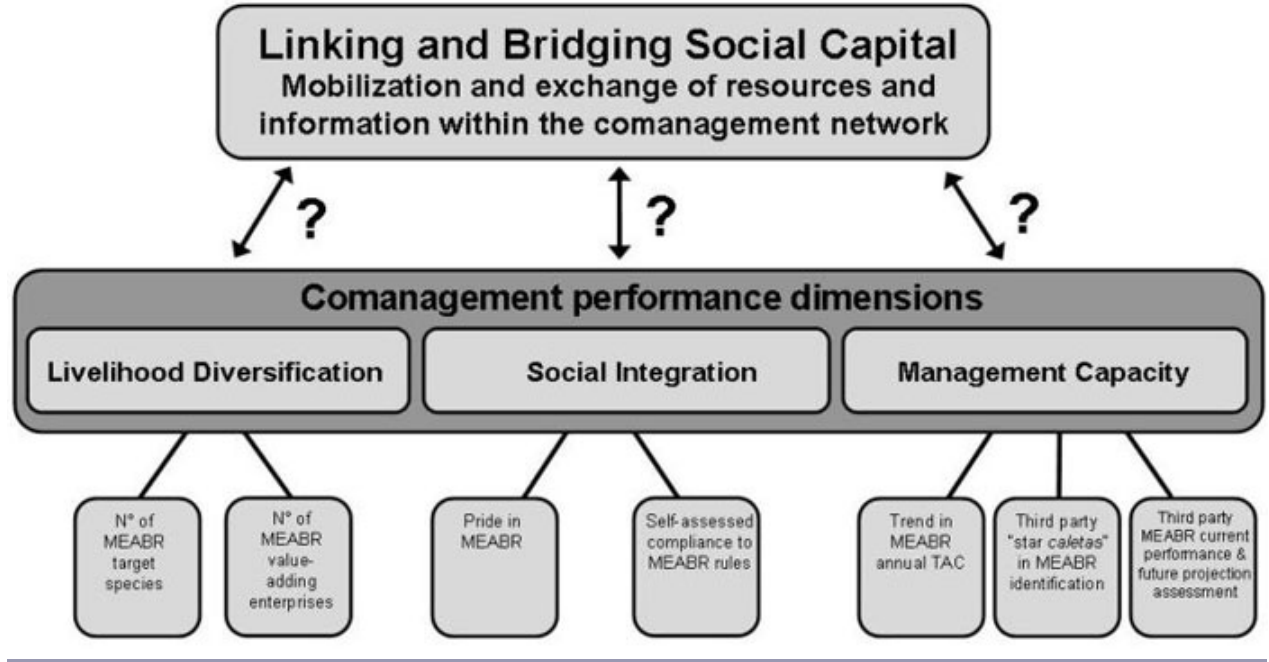
Fig. 1 . Conceptual model. The research aims at assessing the relationship between linking and bridging social capital and comanagement performance of fisher organizations participating in the Chilean coastal MEABR system. Question marks stand for our hypothesis. MEABR = Management and Exploitation Areas for Benthic